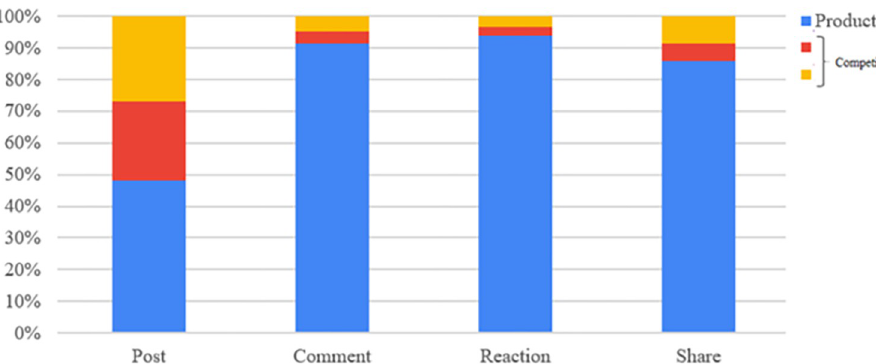
Fig 7. The voice of interactions between products from 13–23 February 2020.